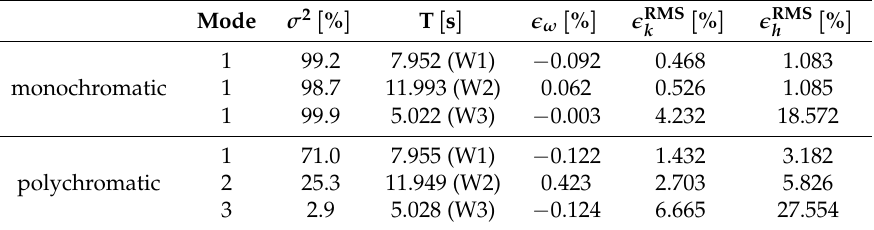
Table 6. Summary of the results of the PCA obtained using phase fitting (without windowing)